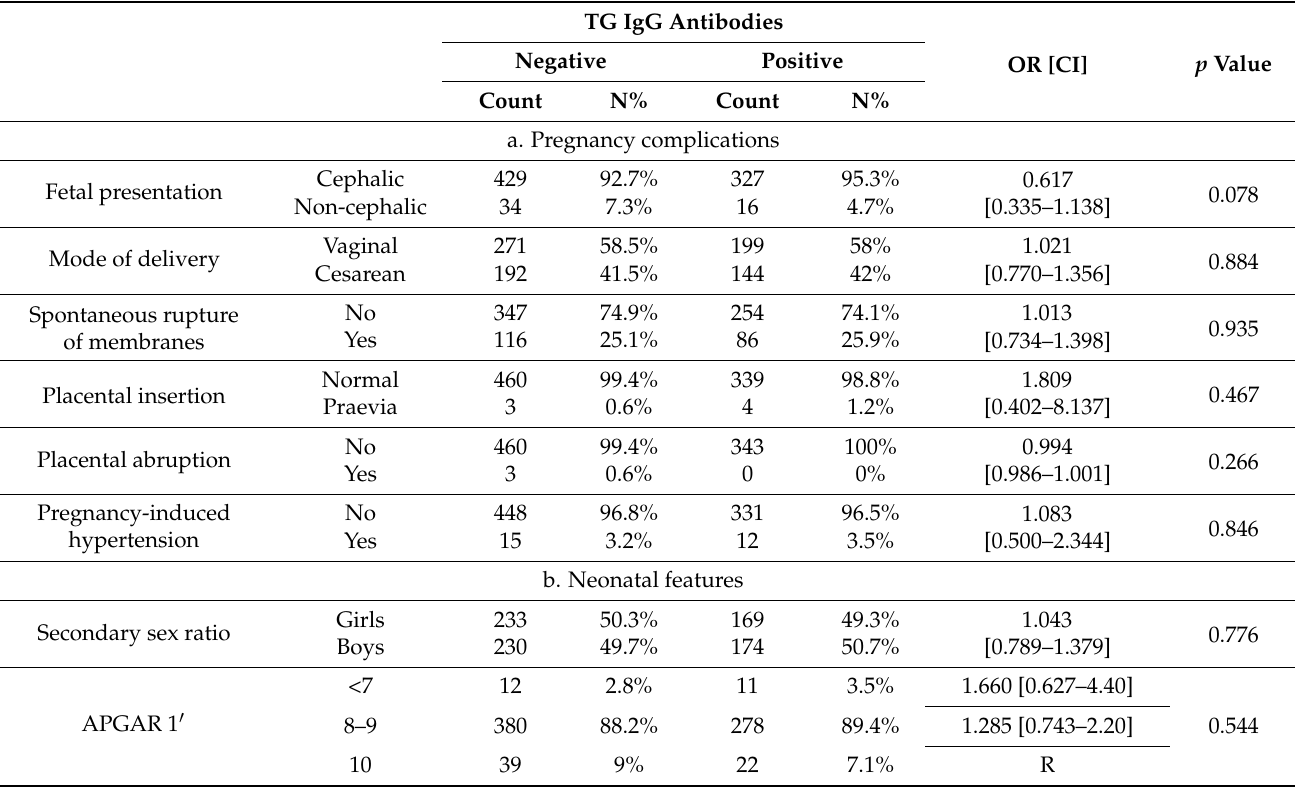
Table 3. Association between latent Toxoplasma gondii infection with pregnancy complications (a) and neonatal features